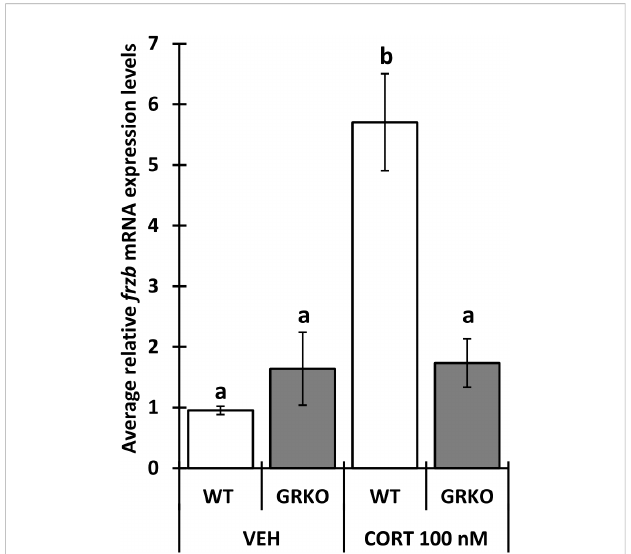
FIGURE 5 Impaired frzb induction in glucocorticoid receptor knockout (GRKO) tails. Premetamorphic wild-type and GRKO tadpoles (NF 54) were treated with vehicle control or 100 nM CORT (corticosterone) for 24 hours followed by tail RNA extraction and quantitative PCR to quantify mRNA expression of frzb and the housekeeping gene rpl8 . Bars represent mean mRNA levels relative to rpl8 and normalized to a vehicle control sample. n = 10 tail samples per treatment. Error bars represent SE. Letters indicate signi fi cant groups, p <